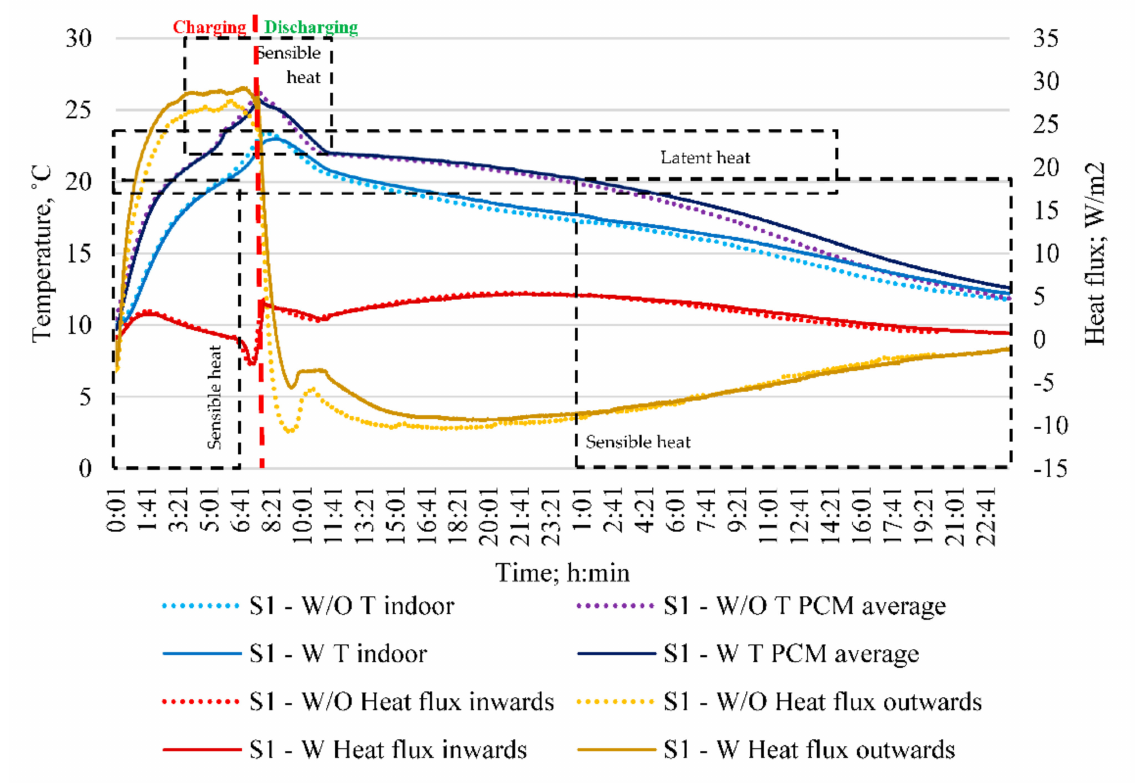
Figure 8. The “indoor space” and average PCM temperatures, inwards and outwards heat fluxes in Setup S1 (Fresnel lens + Cone + Aerogel) variations with (W) and without (W/O) an adjustable insulation